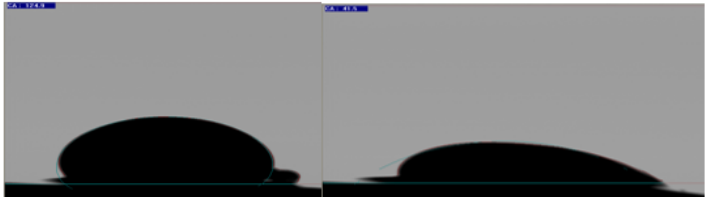
Figure 6. Pendant drop method contact angle measurement between oil-saturated, six weeks aged core plug and oil drop at time step 0 min (left side) and after 60 min (right side).